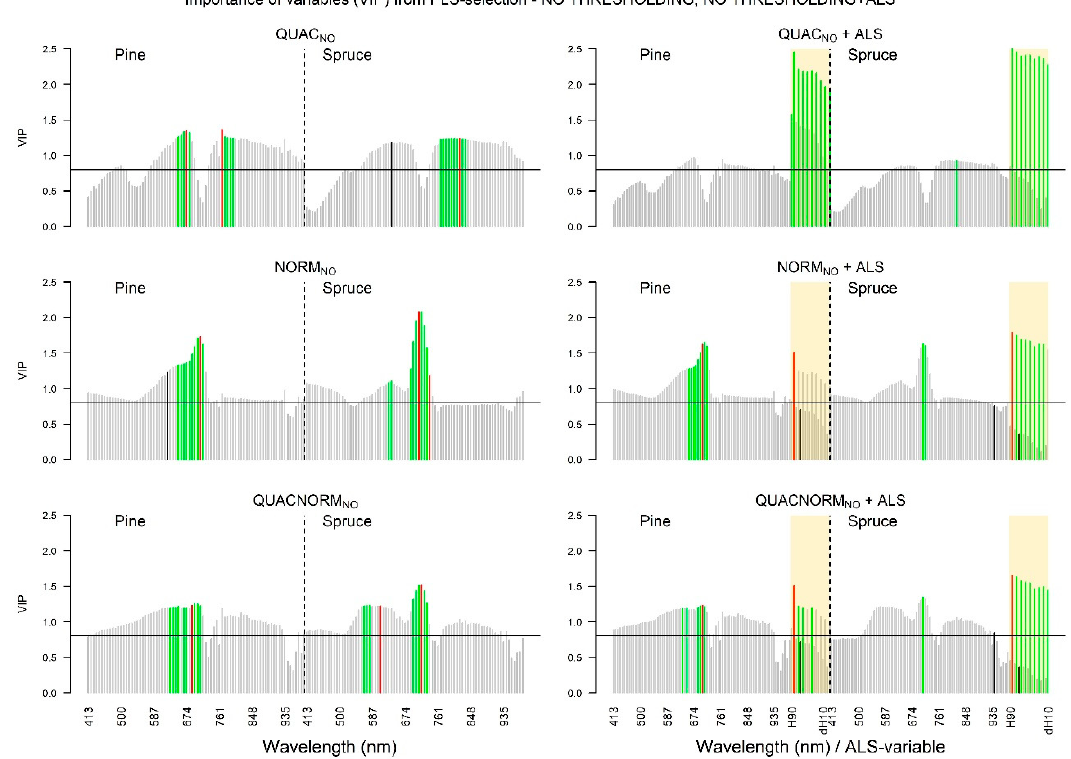
Figure 3. Variable importance for projection (VIP) values from partial least squares (PLS) analysis with site index as a response for hyperspectral variables, and hyperspectral variables in combination with ALS variables. In each panel, results for pine appear on the left, and results for spruce appear on the right. The 10 top-ranking variables according to VIP appear in green. Variables among the top-ranking variables that were included in the subsequent modelling appear in red. Black bars indicate variables that were selected in the modelling, but that were not among the top 10. The results in each panel show variables derived from hyperspectral data where pixels were selected without any thresholding, but with different preprocessing; upper left: atmospherically corrected hyperspectral data; middle left: normalized hyperspectral data; lower left: atmospherically corrected and normalized hyperspectral data; upper right: atmospherically corrected hyperspectral data with ALS variables; middle right: normalized hyperspectral data with ALS variables; lower right: atmospherically corrected and normalized hyperspectral data with ALS variables. In the right column of the panels, the bars representing the ALS variables appear on a yellow background. The sequence of ALS variables from left to right is H90 1999 , dH90, H80 1999 , dH80, ... , H10 1999 , and